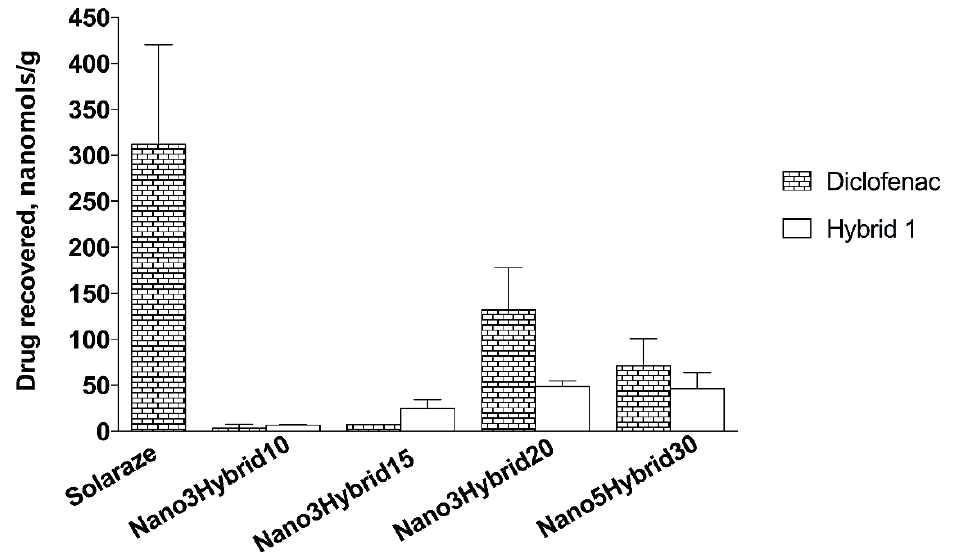
Figure 3. Drug recovered in the pig ear skin after application of the formulation under study Figure3. Drugrecoveredinthepigearskinafterapplicationoftheformulationunderstudy(nanomols / g (nanomols/g of skin, mean  SEM, n = 6). of skin, mean ± SEM, n = 6).